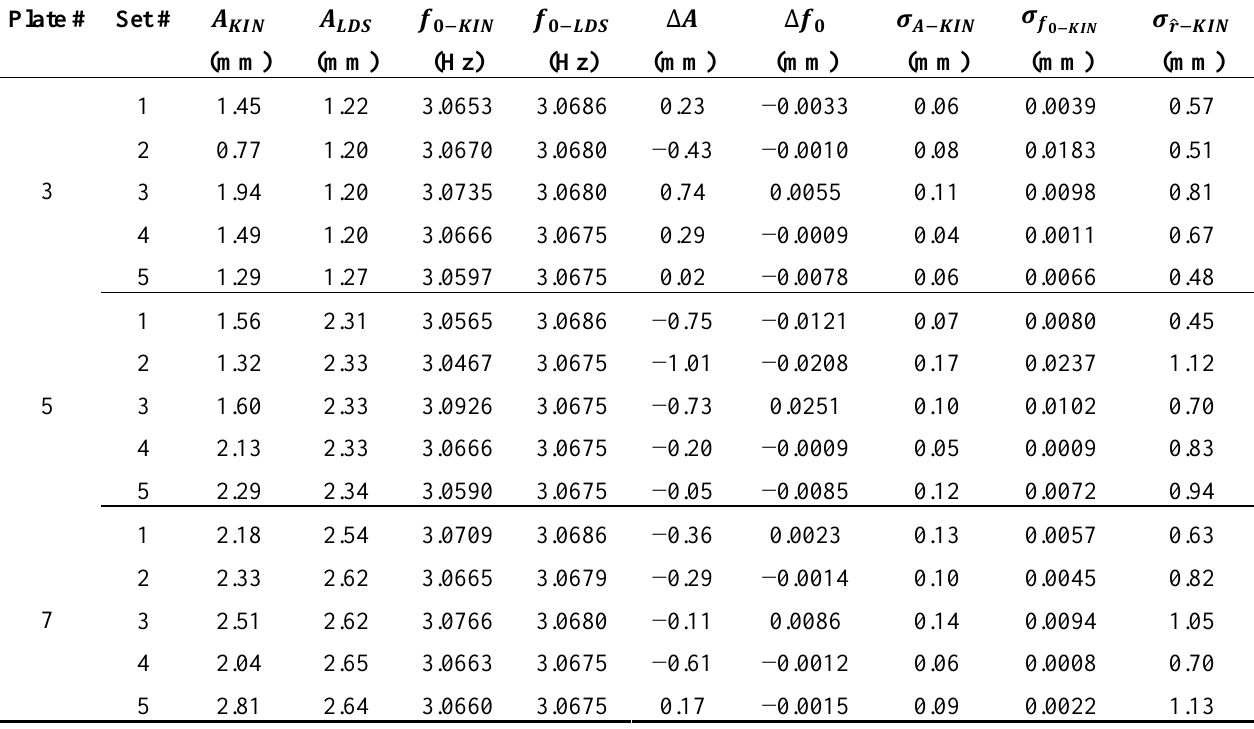
Table 2. Recovered loading frequencies and amplitudes for Plates 3, 5 and 7 ( = 3